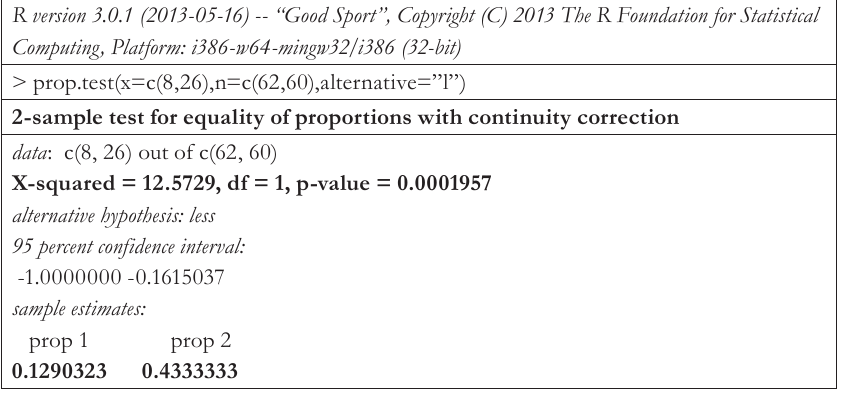
Tab. 4 – One-sample proportion test. Source: Author´s own, RGui386.